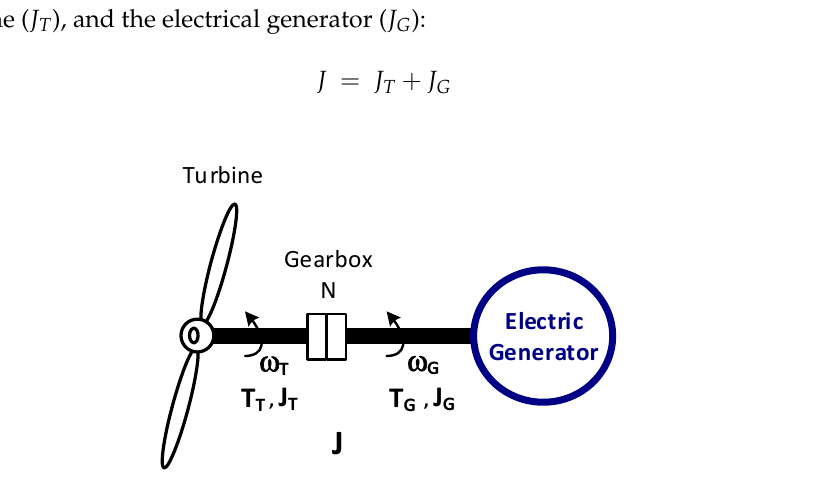
Figure 1. Mechanical model of a generic wind generation system.